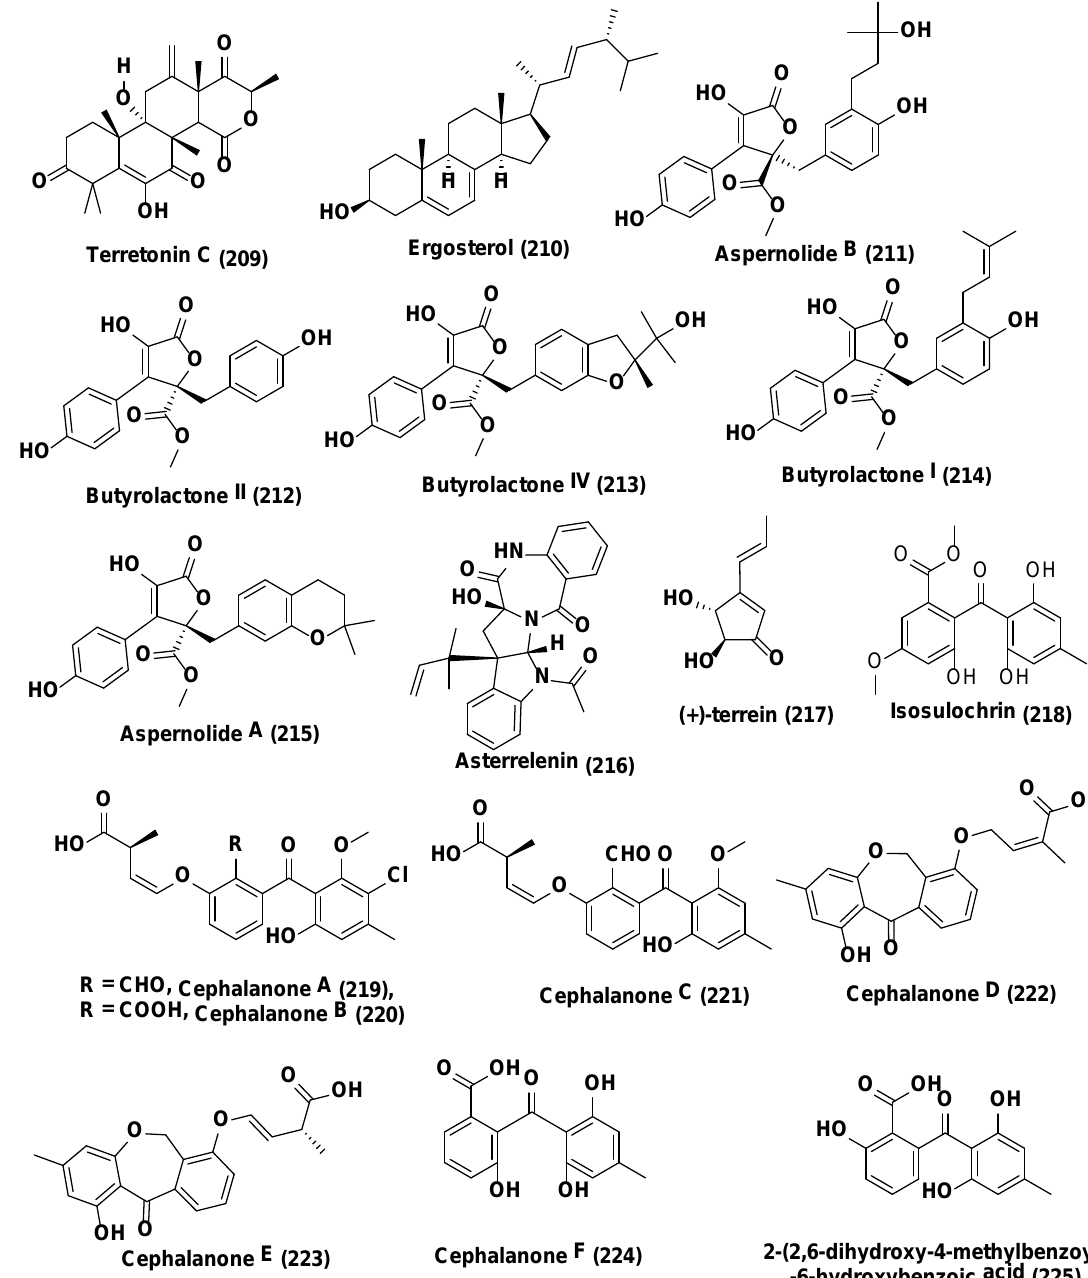
Figure 11. Structures of metabolites obtained from Epigenetic modification in endophytic fungi ( 209 – 225 ).